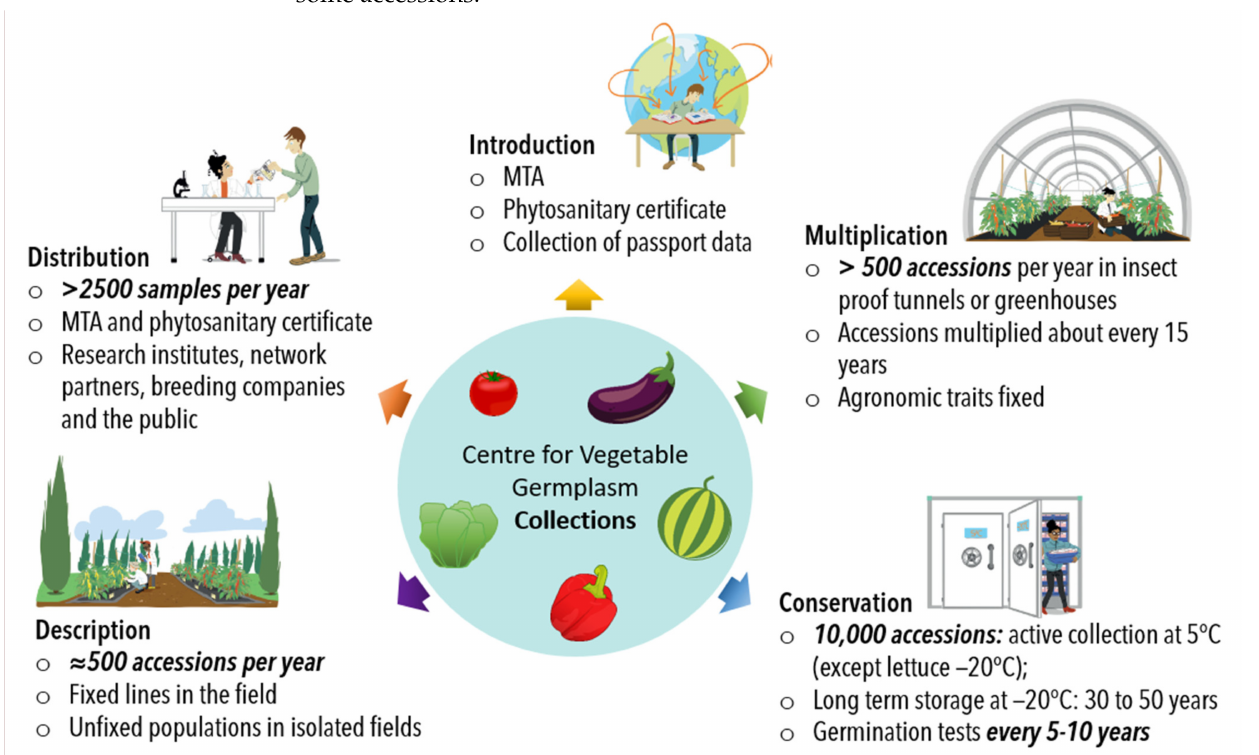
Figure 4. Current procedures for management of the collections at the INRAE Vegetable Germplasm Centre, including the major missions of introduction, multiplication, description, conservation and distribution and with an estimation of the number of samples or accessions involved. The multiplica- tions are mostly carried out by self-pollination. Illustrations Camille Ulrich—Copyright